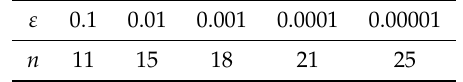
Table 6. Number n of iterations needed by the a priori estimate if started with ( 100,20 ) . ε